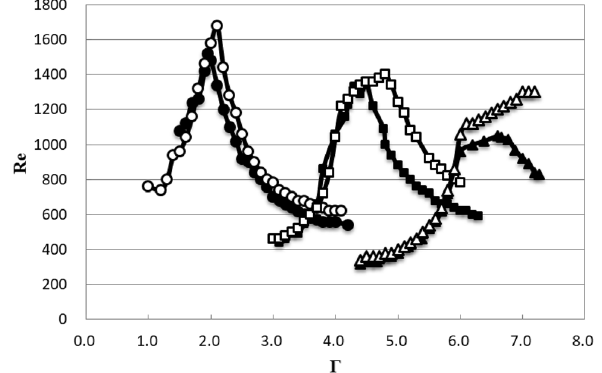
Fig. 12 The critical Reynolds number at which the Taylor flow bifurcates into the wavy Taylor flow: the open symbols denote the numerical results and the filled symbols represent the experimental results [10]. The circle, square and triangle marks show the 2, 4 and 6-vortex modes,